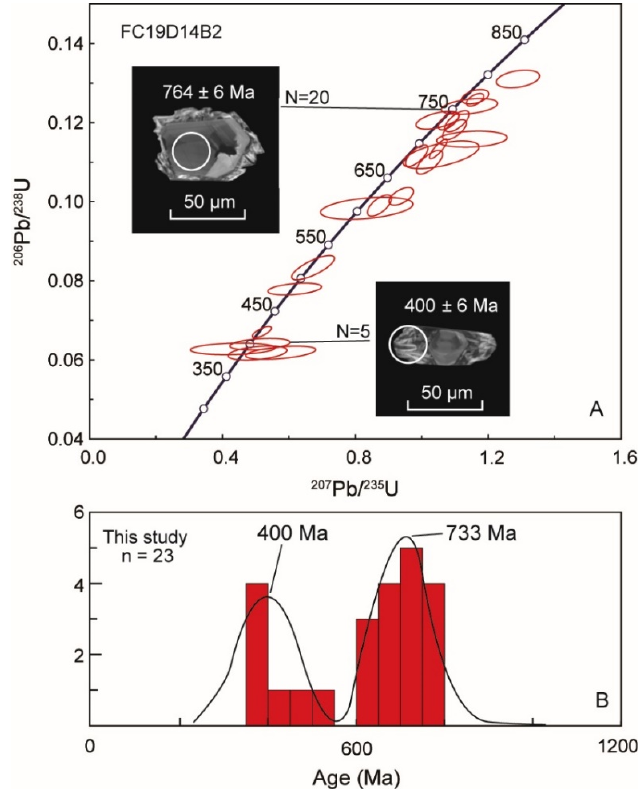
Figure 5. Geochronology diagrams: ( A ) Zircon U–Pb concordia plot and representative cathodoluminescence (CL) images; and ( B ) frequency (bars) and probability density distribution of LA-ICP-MS dates for detrital zircons from a metasedimentary unit at the Baishugang–Wujianfang district (the error ellipses represent 2 σ uncertainties). The location spots for the LA-ICP-MS U–Pb measurements are indicated by the white circles with ages above them.